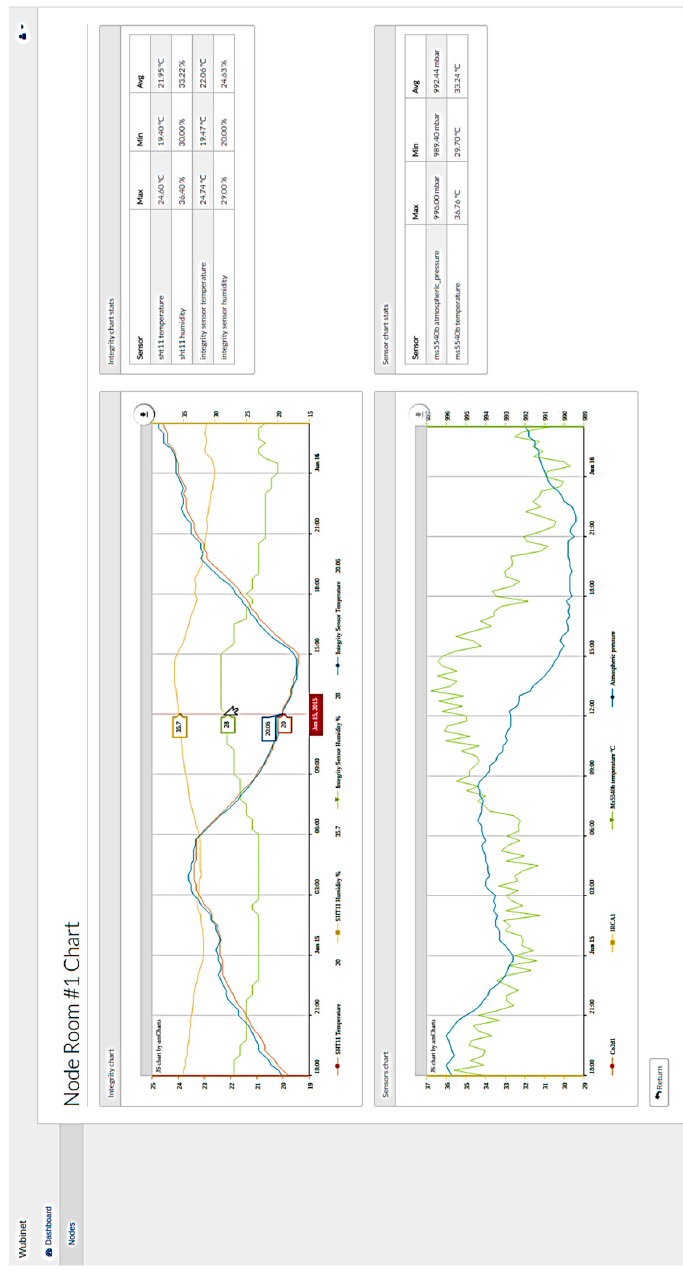
Figure 14. Web application screenshot.